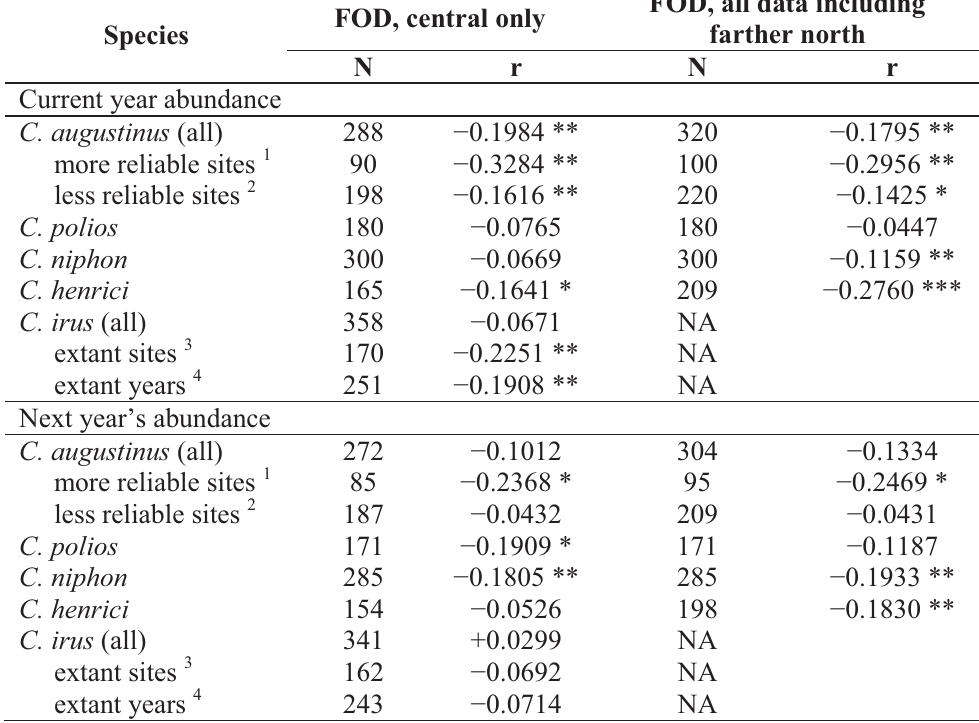
Table 9. Spearman rank correlation coefficients (r) of abundance (individuals per hour on peak count per site per year) and first observed date (FOD), calculated either using surveys only in central Wisconsin or using all surveys including from northern Wisconsin and northeastern Minnesota. * p < 0.05, ** p < 0.01, *** p <